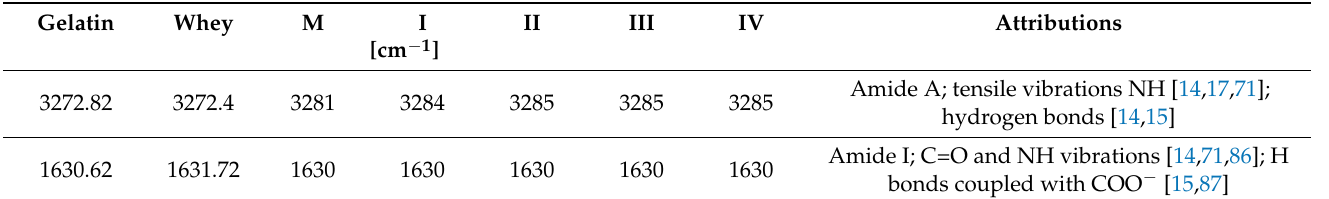
Table 2. The main vibration bands of GO-reinforced hydrogels based on whey and gelatin and their